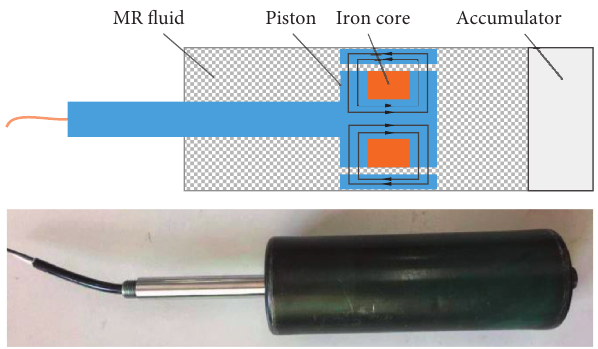
Figure 1: Structure of MR